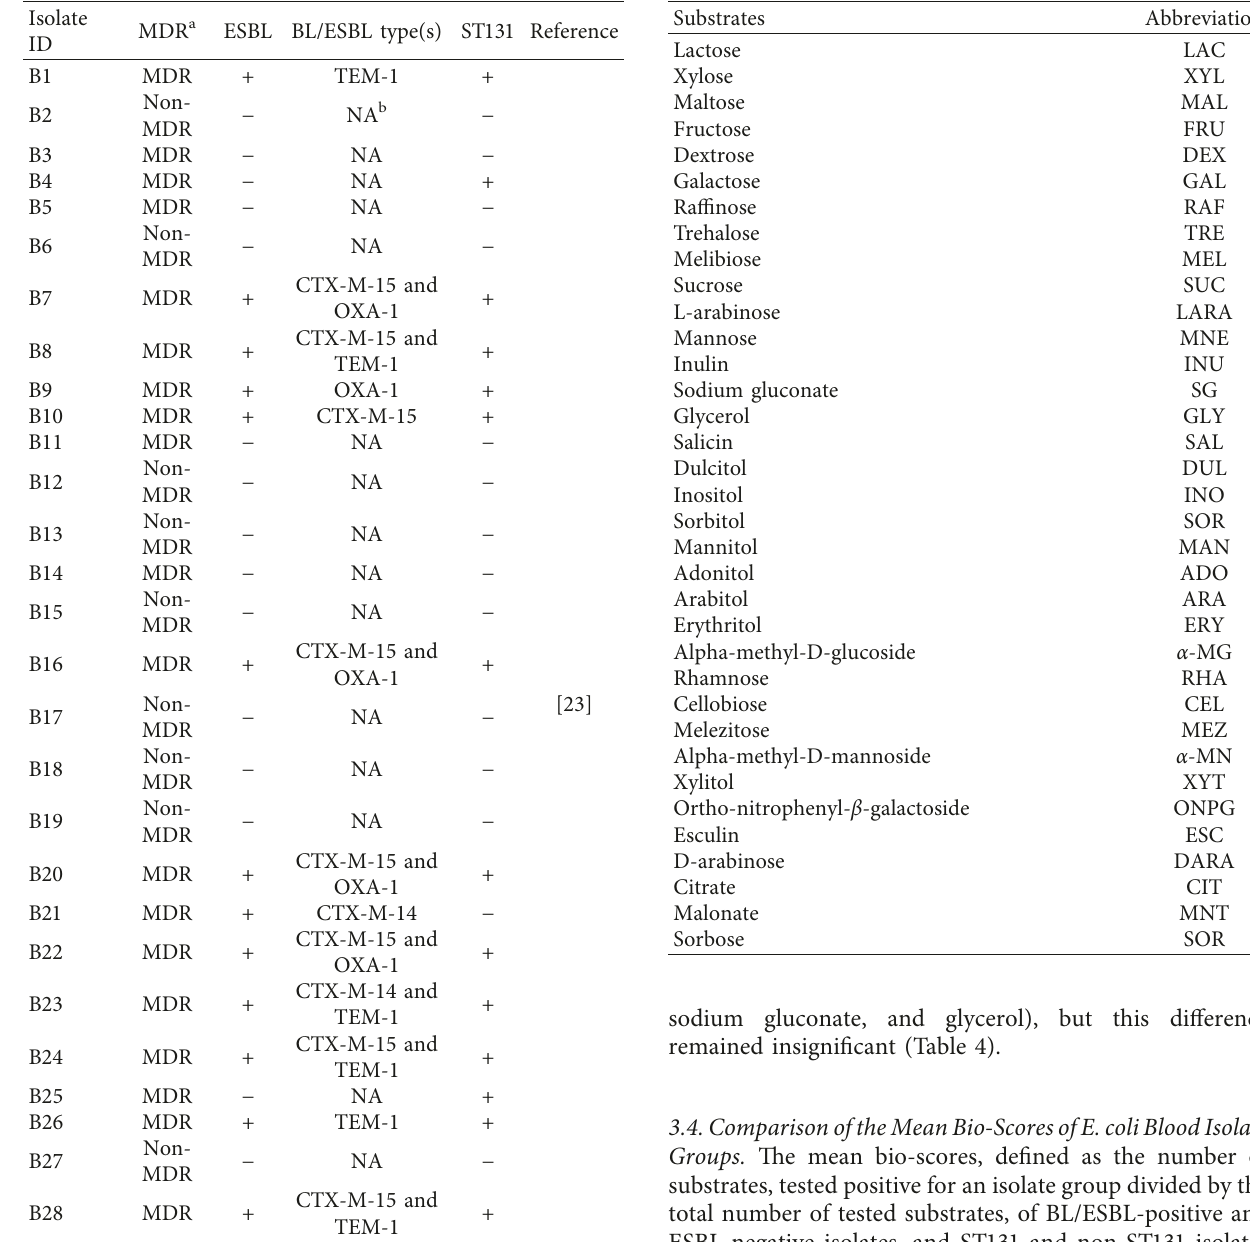
Table 2: List of substrates used in this